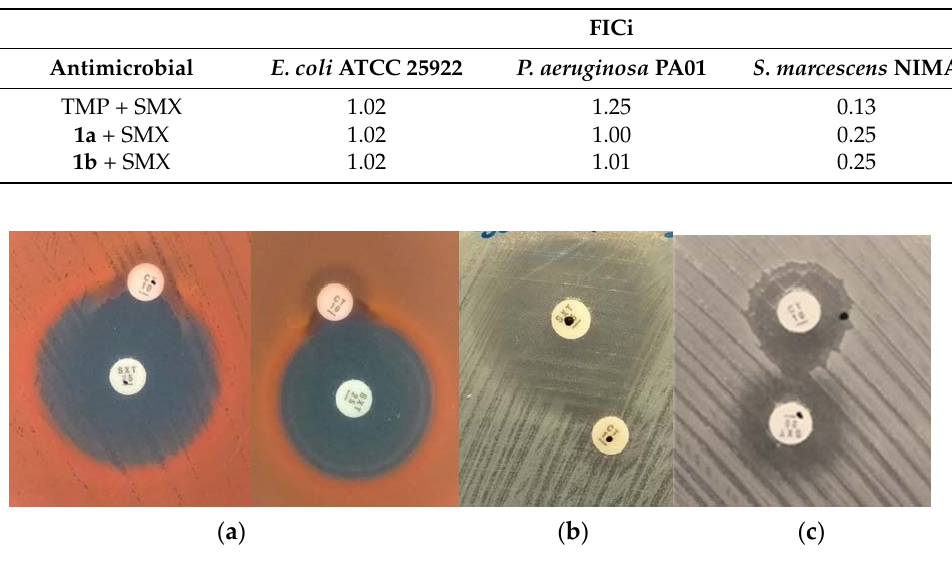
Figure 2. Interaction between colistin and TMP-SMX in ( a ) S. marcescens NIMA; ( b ) E. coli ATCC 25922, and ( c ) P. aeruginosa PAO1.